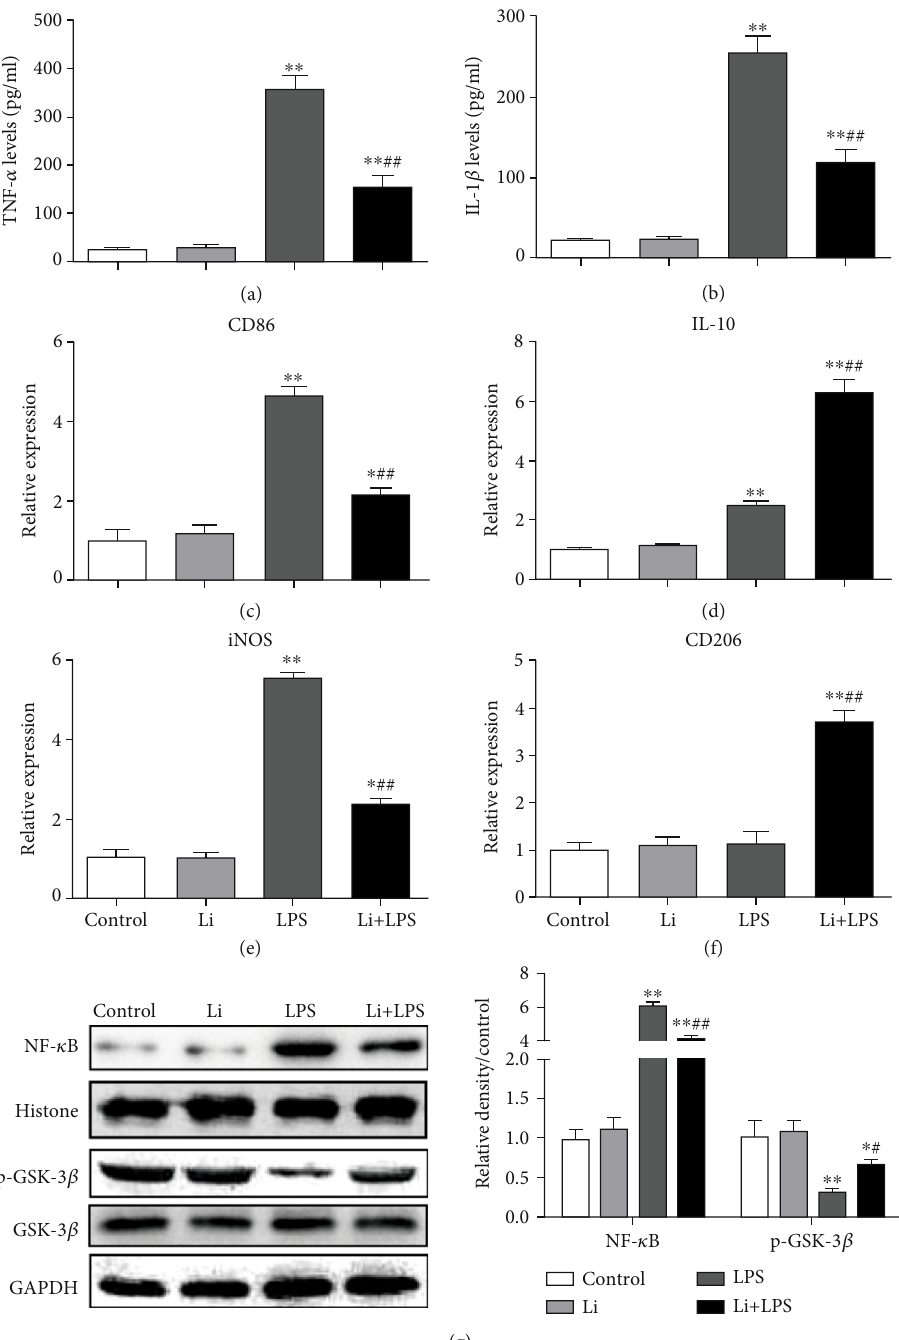
Figure 6: LPS-induced expression of M1 markers is suppressed by GSK-3 β inhibition in vitro. (a – f) Expression of M1 (TNF- α , IL-1 β , CD86, and iNOS) and M2 (IL-10 and CD206) markers in primary microglia was examined using ELISAs or quantitative RT-PCR. (g) Levels of NF- κ B and p-GSK-3 β in the rat hippocampus were detected using Western blotting with speci fi c antibodies. The levels of proteins were quanti fi ed by ImageJ, and the levels of p-GSK-3 β and NF- κ B were normalized to GSK-3 β or histone levels (p-GSK-3 β /GSK-3 β ratio and NF- κ B/histone ratio). Each value was then presented relative to the ratio of control, which was set to 1. The data are presented as means ± s : e : m : ( n = 3 ). ∗ P < 0 : 05 and ∗∗ P < 0 : 01 compared with the control group. # P < 0 : 05 and ## P < 0 : 01 compared with the LPS